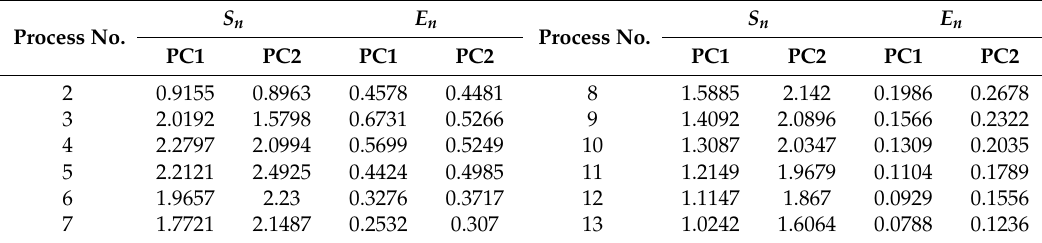
Table 1. The indexes of speedup factor and parallel computing efficiency for the proposed bi-level distribution network planning (DNP)